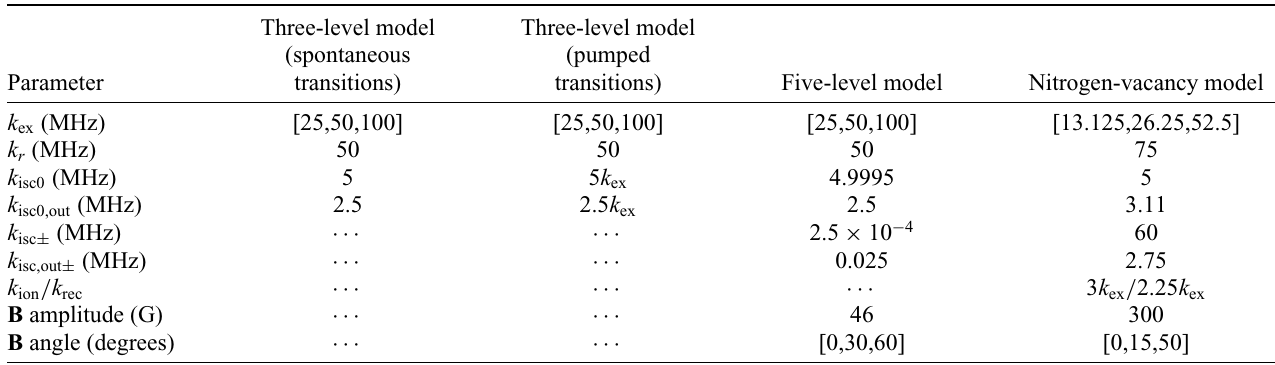
TABLE I. The simulation parameters for Fig.